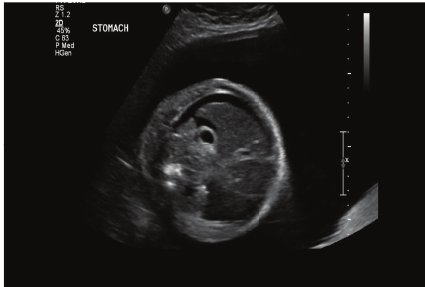
Figure 3: Cross sectional view of the abdomen showing abdominal ascites.